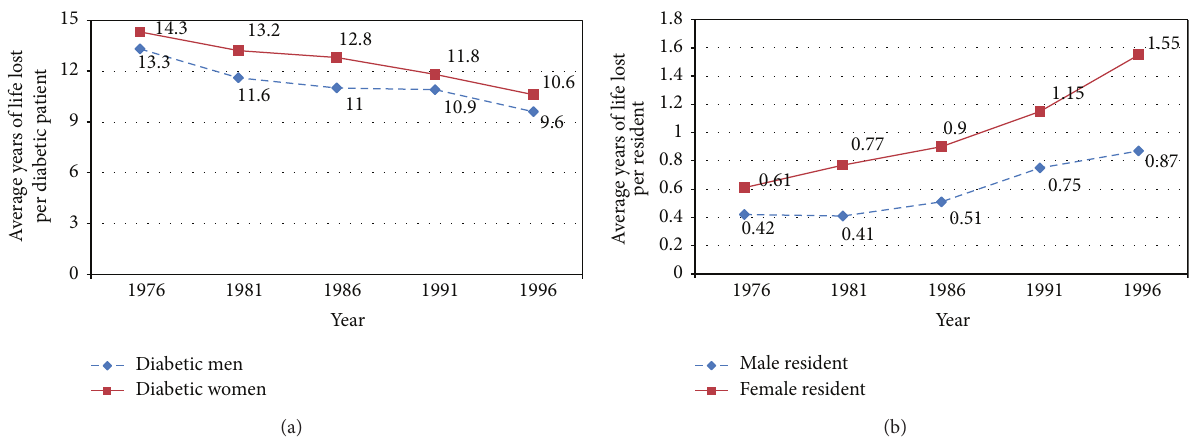
Figure 1: The average of Years of Life Loss (a) per diabetic patient and (b) per resident in Shanghai between 1976 and 1996.